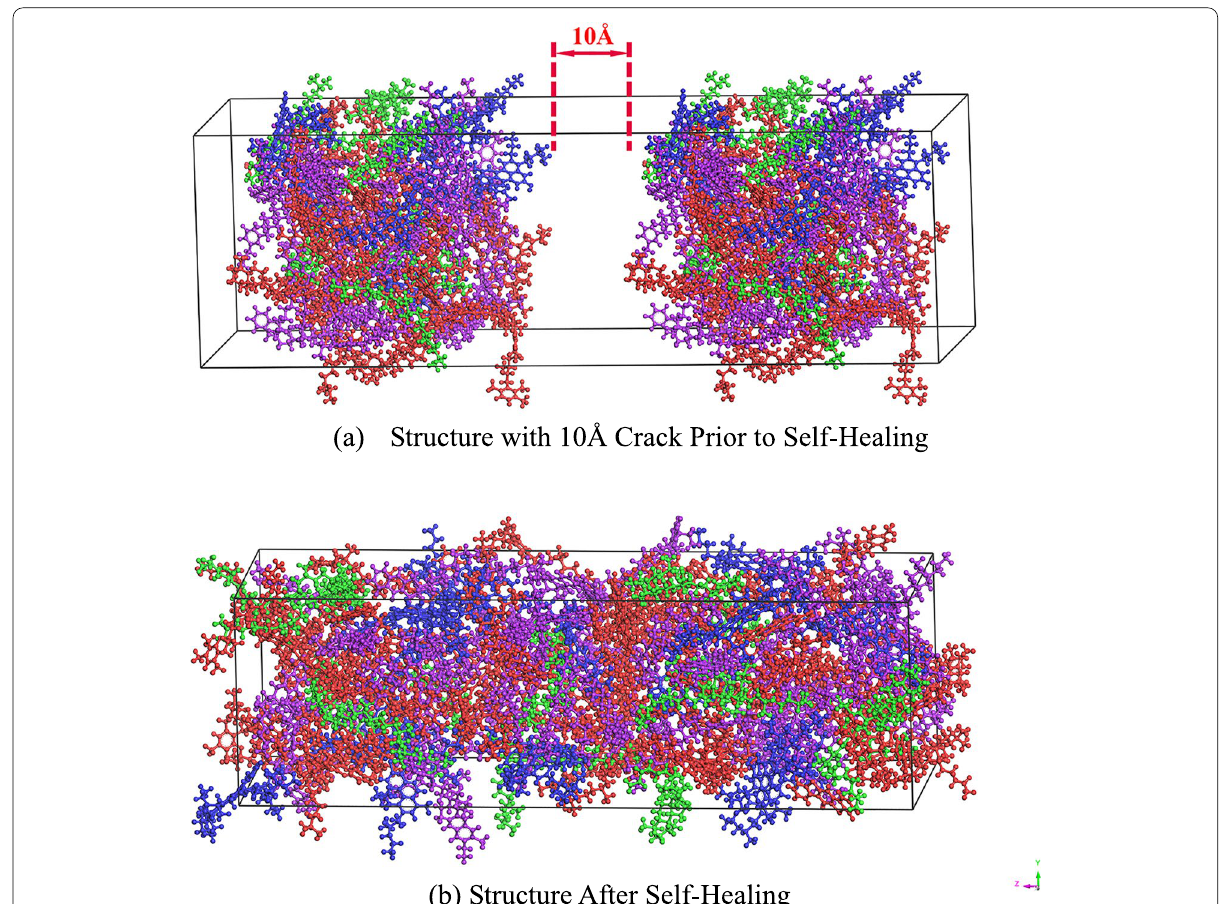
Fig. 5 Self-Healing Process in the Virgin Asphalt Model: ( a ) Structure with 10 Å Crack Prior to Self-Healing and ( b ) Structure After Self-Healing (asphaltene, resin, aromatic, and saturate are represented as blue, purple, red, and green, respectively)